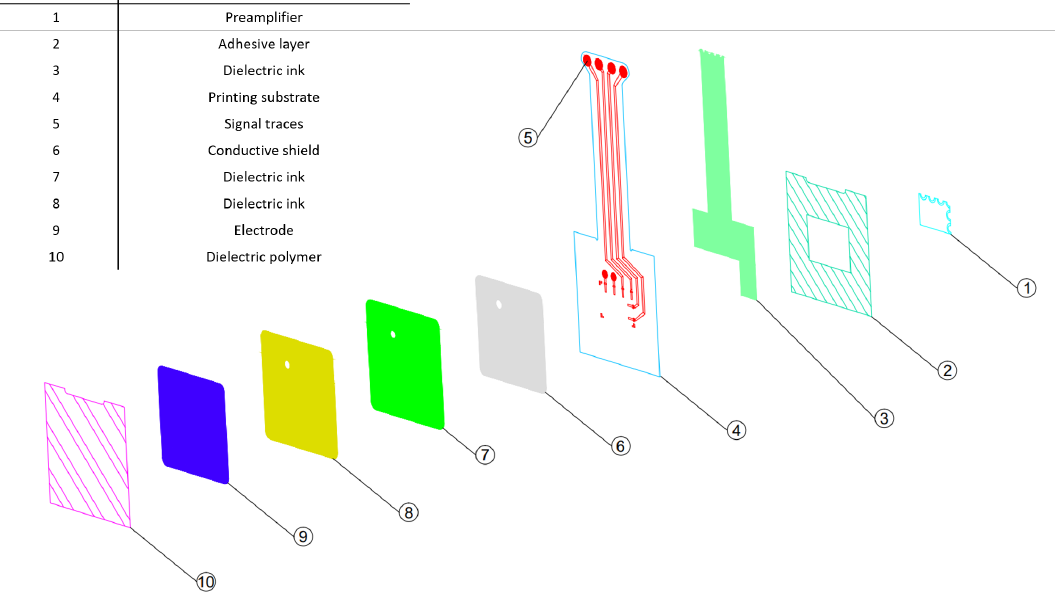
Figure 5. Hybrid flexible electrode-layer